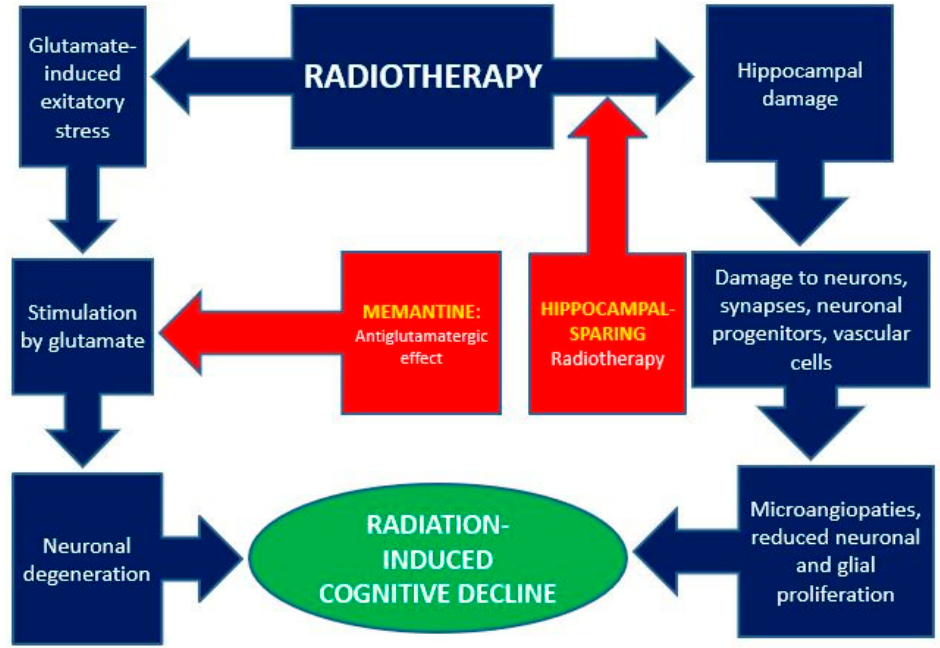
Figure 1. Mechanisms of radiation-induced cognitive impairment (blue) and possible ways of prevention (red) .